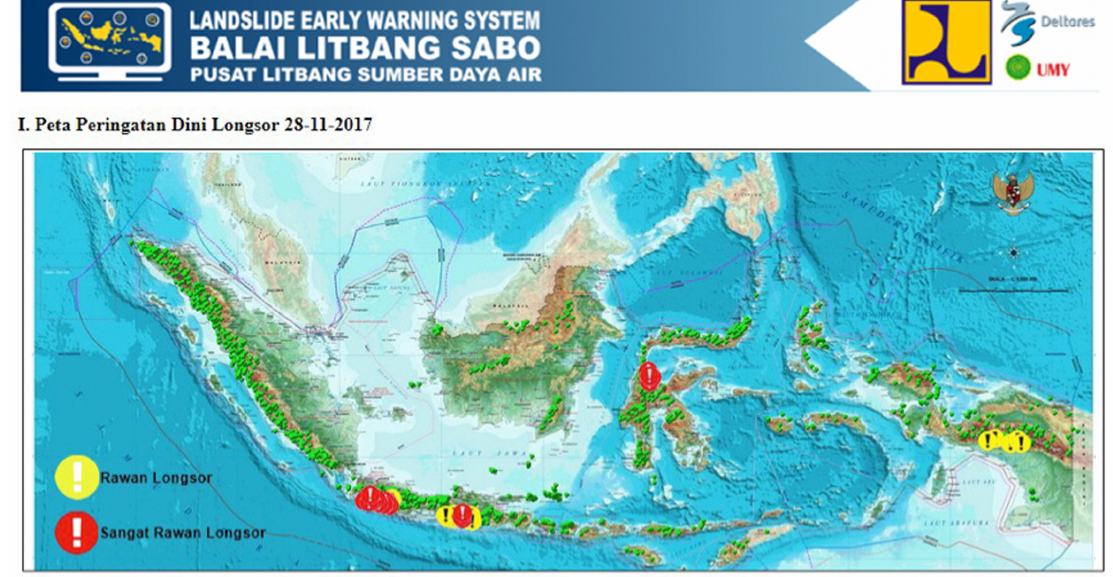
Figure 7. The warning signals issued by the Balai Litbang Sabo Landslide Early Warning System (BLS LEWS) for 28 November